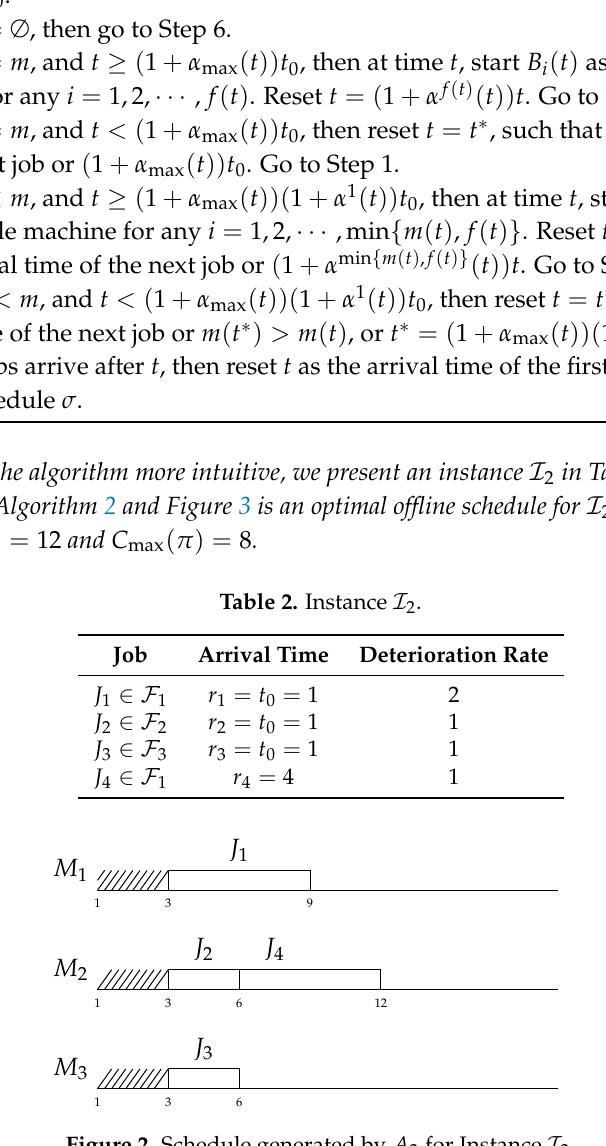
Figure 2. Schedule generated by A 2 for Instance I 2